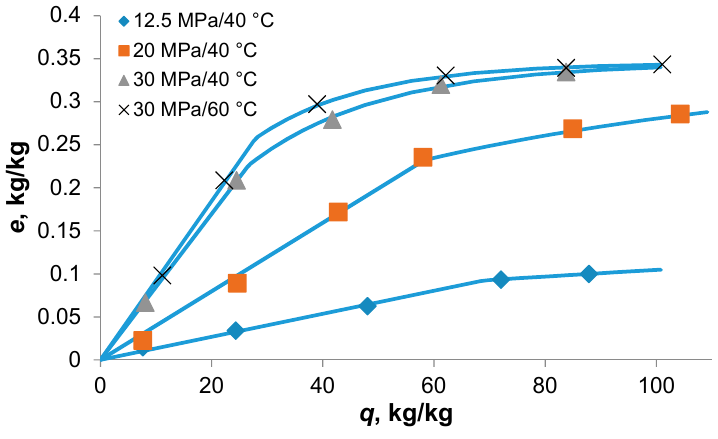
Figure 6. Extraction yield from Nannochloropsis sp. [11]: the symbols represent experimental data and the extraction curves were calculated with the lumped parameter model.